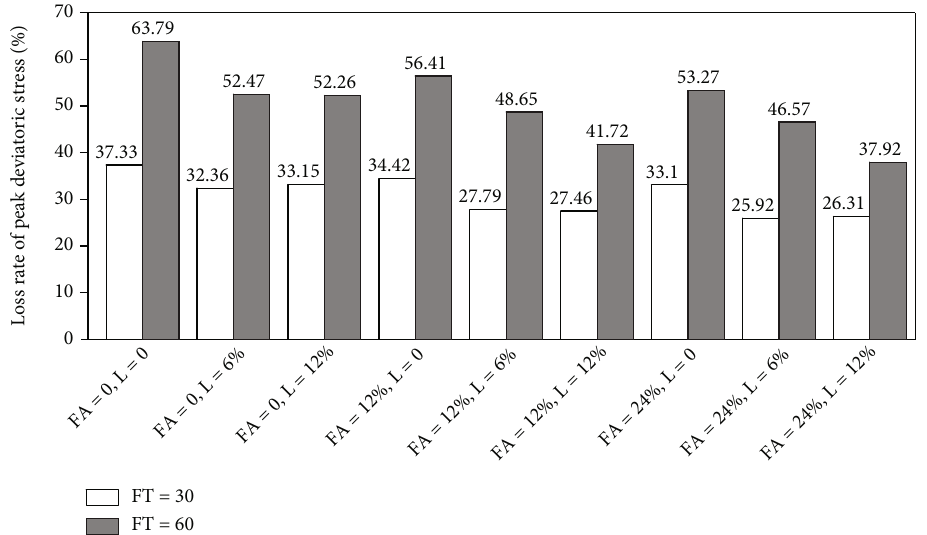
Figure 28: Loss rate of peak deviatoric stress after freeze-thaw cycles.